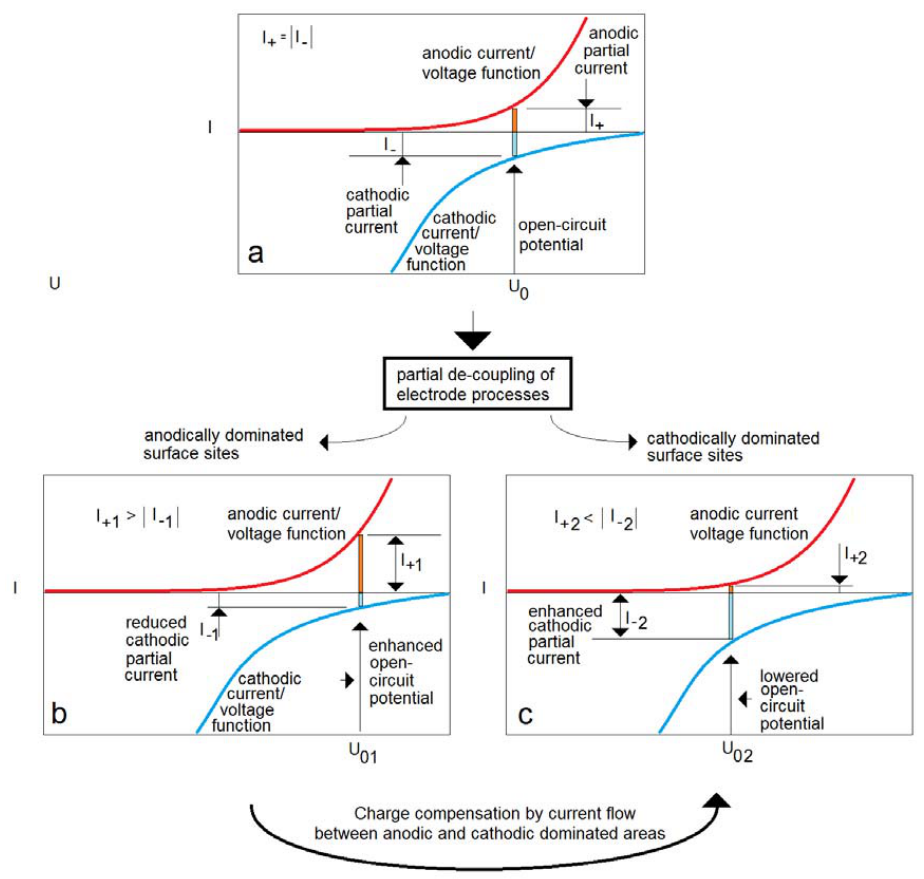
Figure 2. Electrochemical model of a growing or corroding metal nanoparticle in colloidal